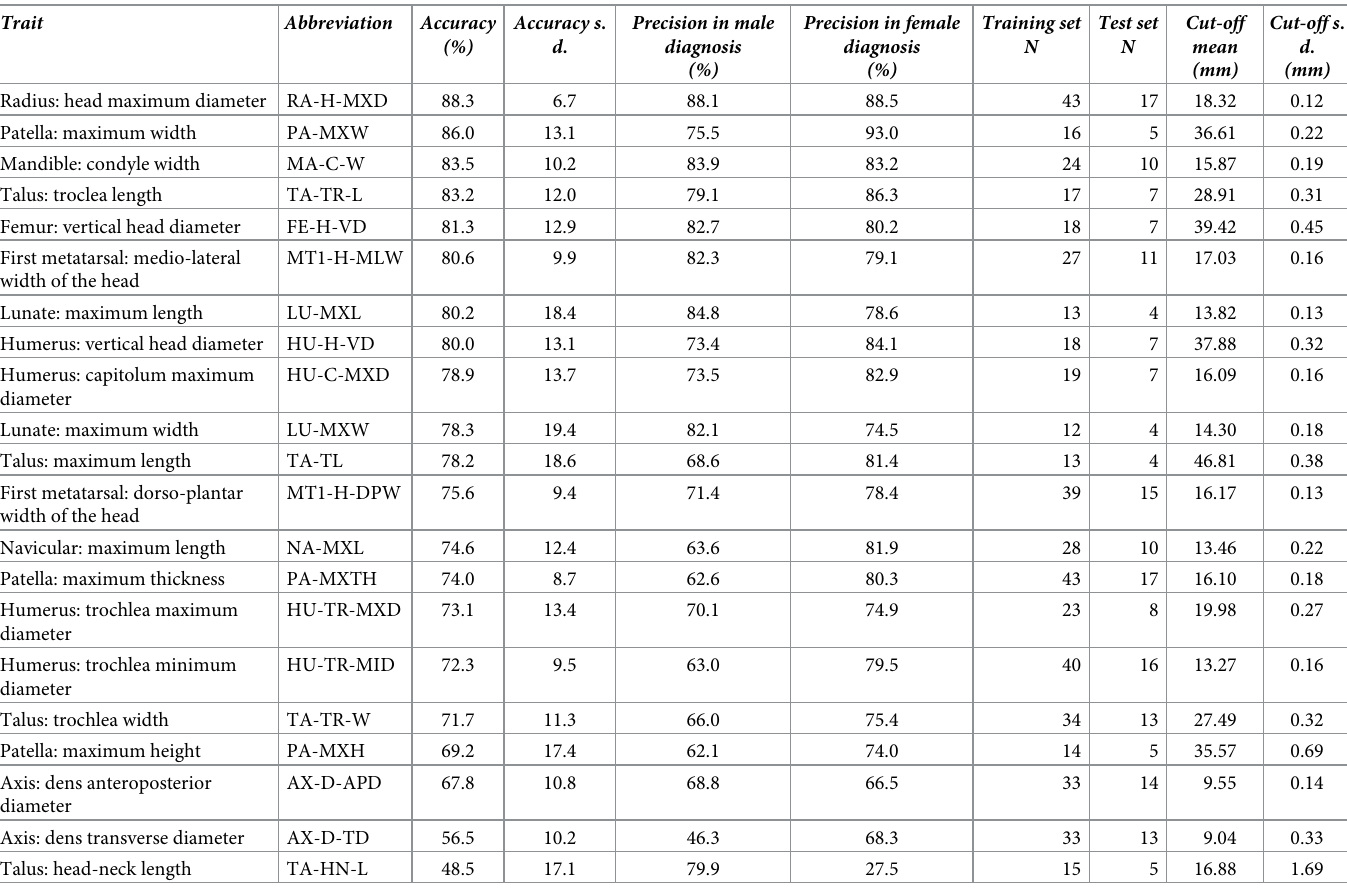
Table 4. Cross-validation results in sex